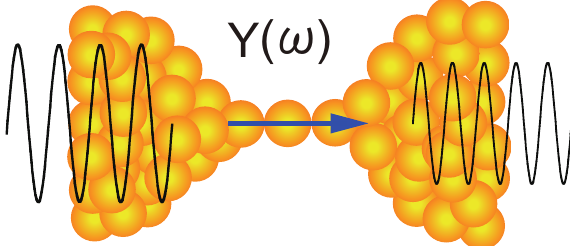
Figure 1. Transmission of a high-frequency signal thorough a single-atom